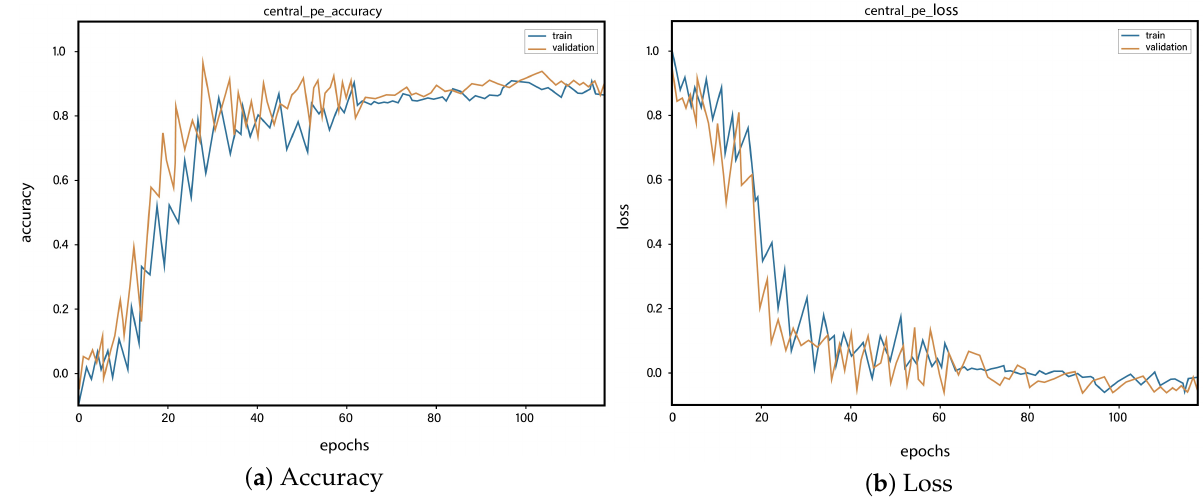
Figure 9. Training vs. validation accuracy and loss for the class: Right-sided PE.